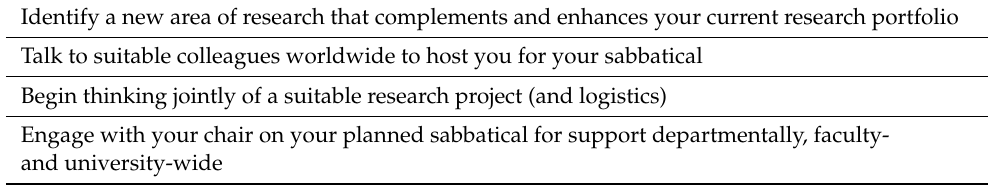
Table 1. 2–3 years before your Planned sabbatical.